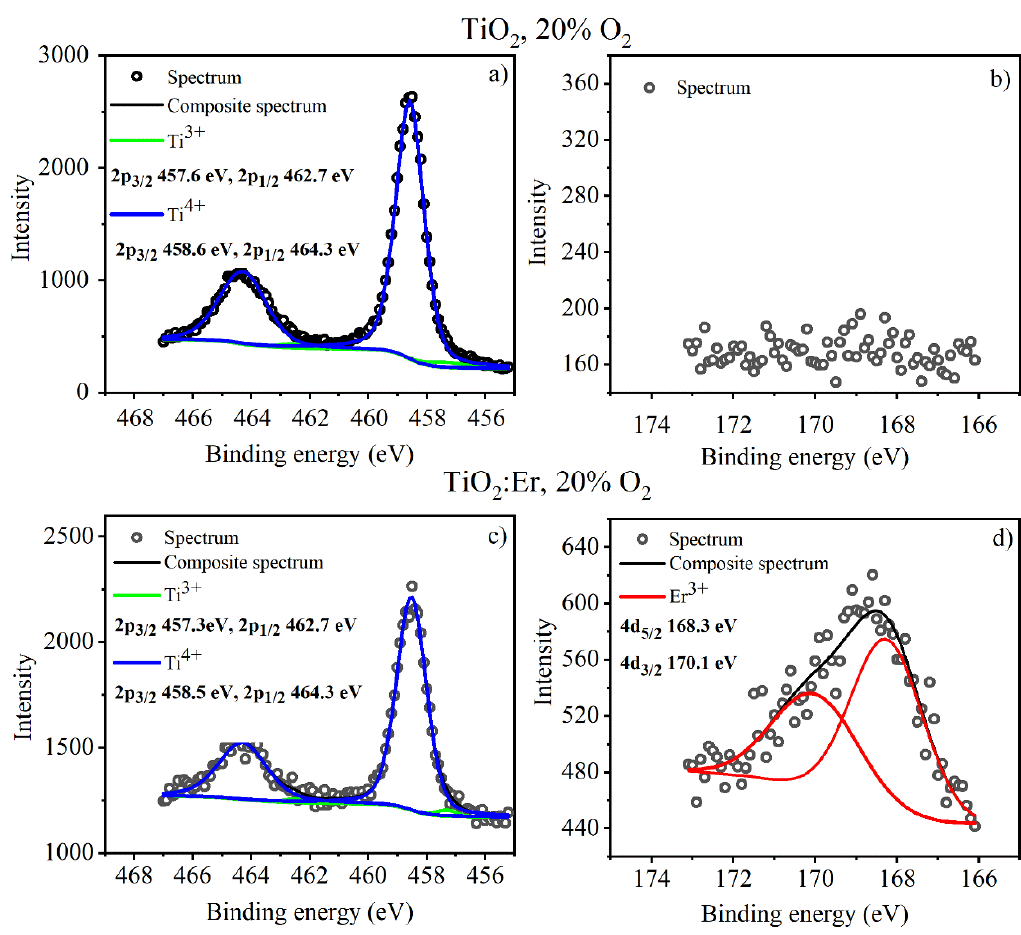
Figure 6. XPS spectra for the thin films of: ( a , b ) TiO 2 —deposited at 20% O 2 , and ( c , d ) TiO 2 :Er—deposited at 20% O 2 .